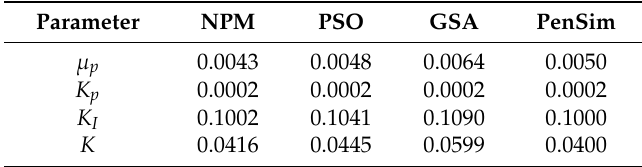
Table 6. Constraints of the critical variables.